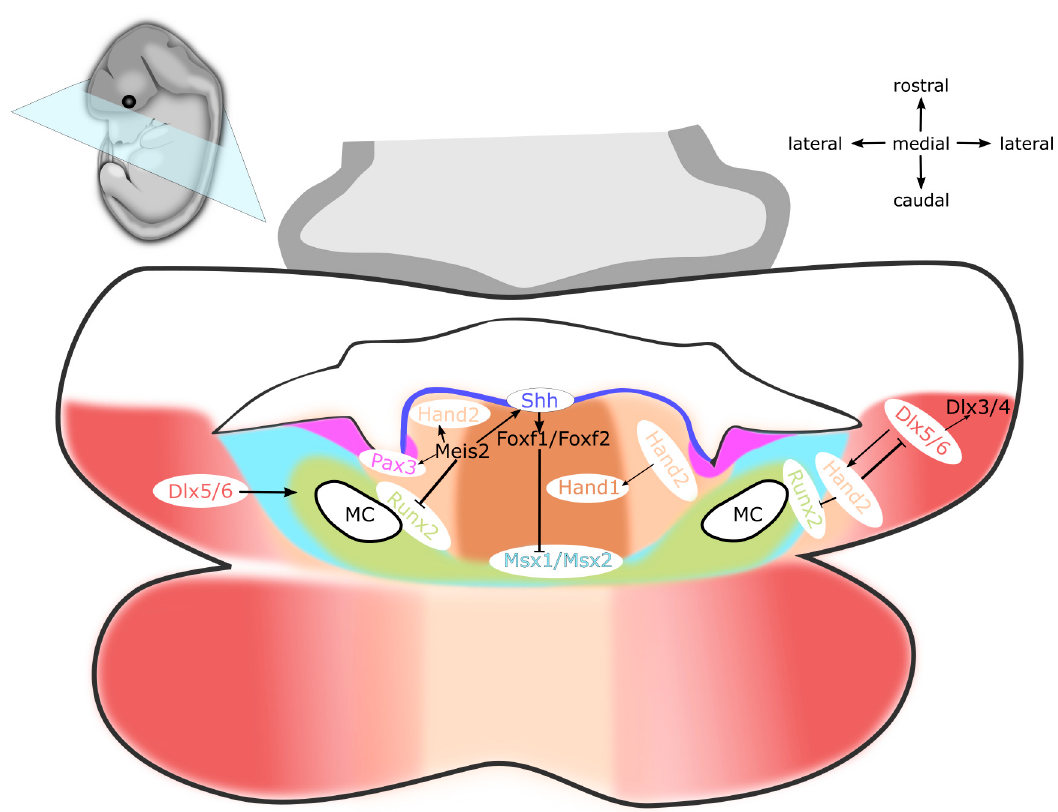
Figure 1. Schematics of a frontal section through developing oral cavity of a mouse embryo at E12. Dlx5/Dlx6 are expressed in ectomesenchyme of the mandibular process and the hyoid arch. Hand1/Hand2 and Meis2 are expressed in ectomesenchyme in the medial region of the mandibular process and the hyoid arch, which also includes the lingual ectomesenchyme. Msx1 and Runx2 are expressed within the primordium of prospective dentary bone. Pax3 is expressed in the ectomesenchyme around the alveolingual sulcus, which represents an anatomical boundary between the dentary bone and tongue. Shh is expressed in the lingual epithelium, whereas Foxf1/Foxf2 are expressed in the lingual ectomesenchyme. Abbreviations: E, embryonic day; MC, Meckel’s cartilage. Expression domains of genes written in black text are not highlighted in the figure.